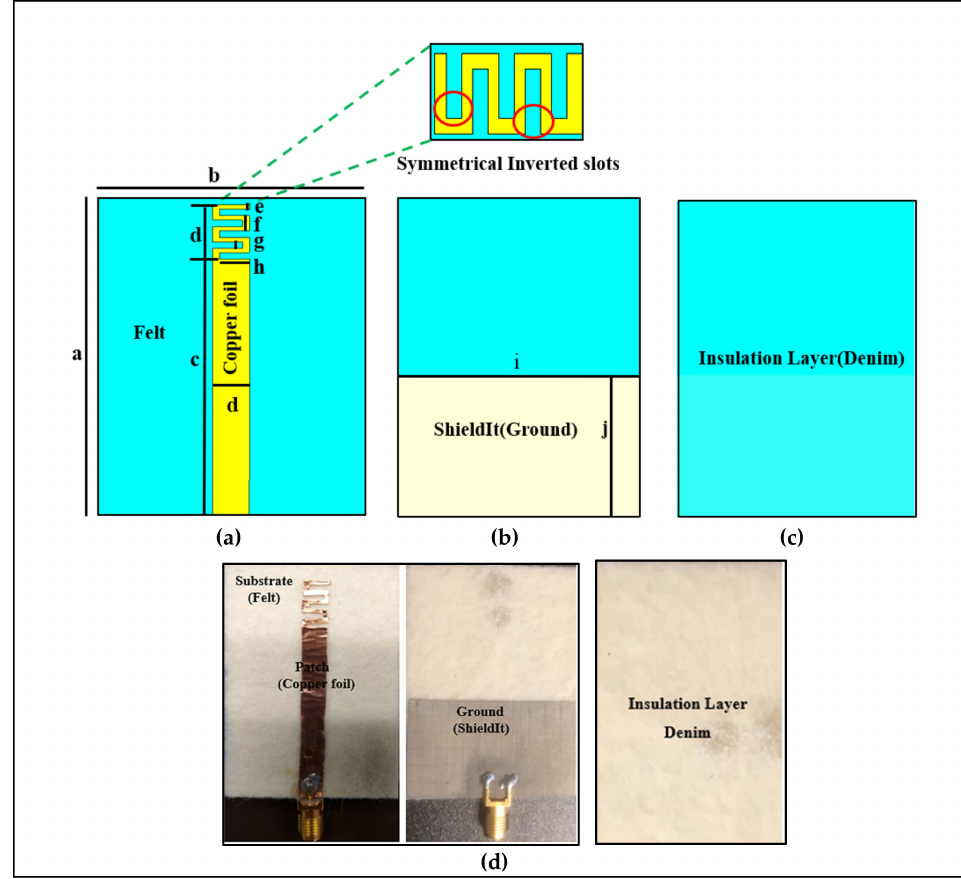
Figure 2. Design and dimensions of the planar meander line antenna, (dimensions are given in mm): ( a ) the top side; ( b ) the bottom side; ( c ) the insulation layer; and ( d ) the fabricated